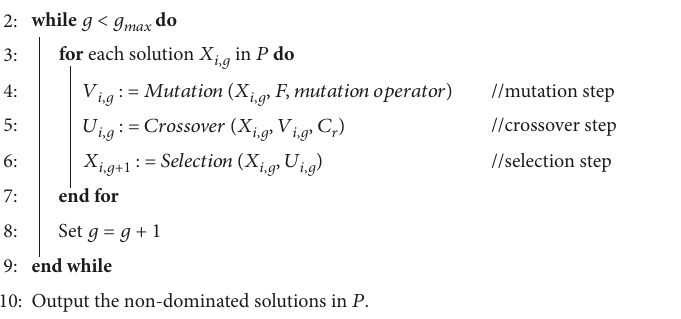
Figure 3: Procedure of classical